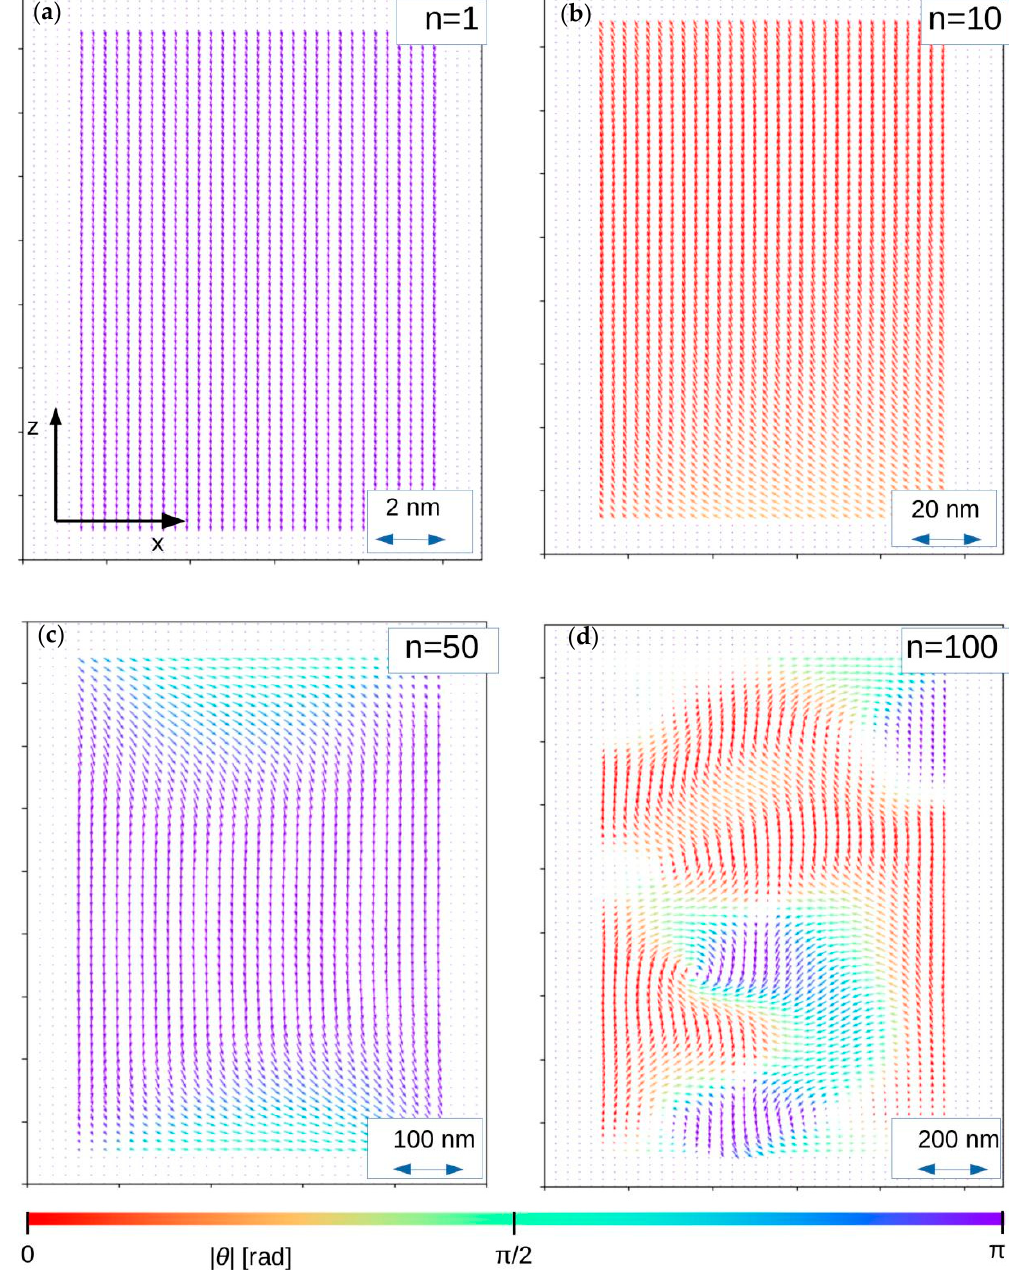
Figure 5. Magnetic moment configurations for 3D tetragonal box in central z-x plane for different n parameters. In this figure, θ is the angle between magnetic moment direction and the z-axis . ( a ) n = 1; ( b ) n = 10; ( c ) n = 20; ( d ) n = 100.